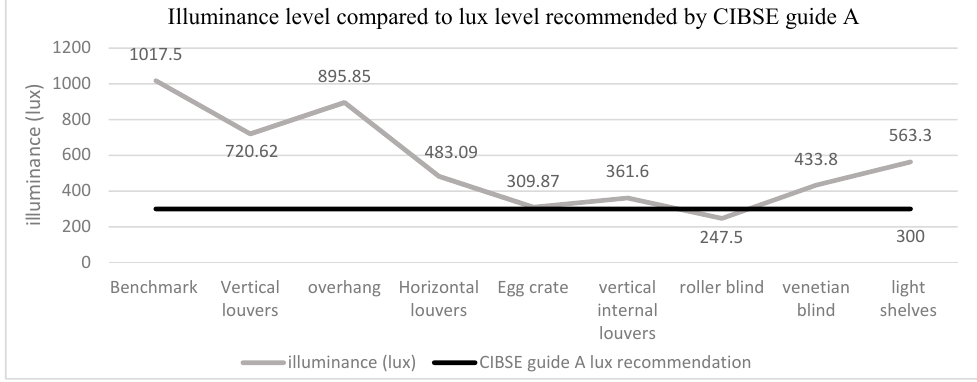
Figure 6. Illuminance level of shadings compared to CIBSE value.